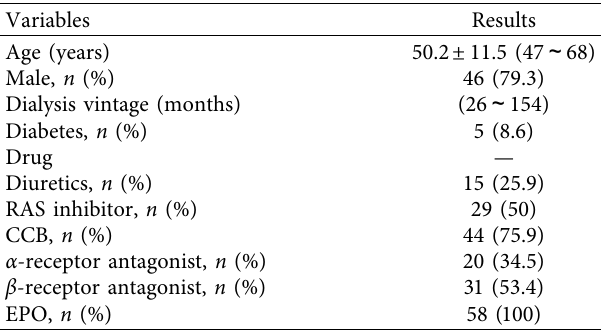
Table 1: Characteristics of patients.